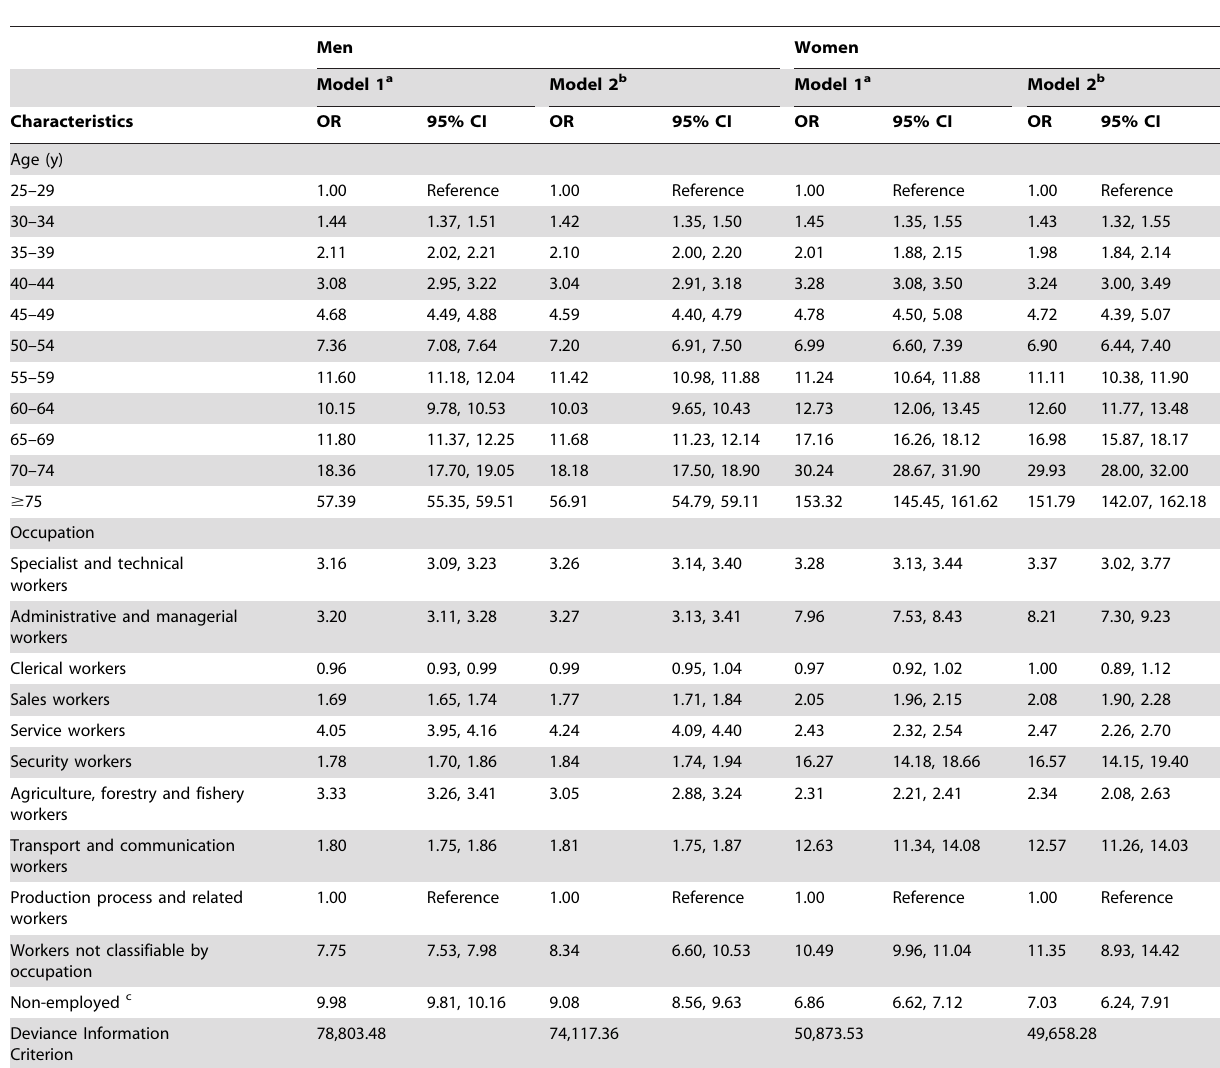
Table 1. Odds ratios for all-cause mortality associated with fixed parameters, along with the Deviance Information Criterion, Japan,